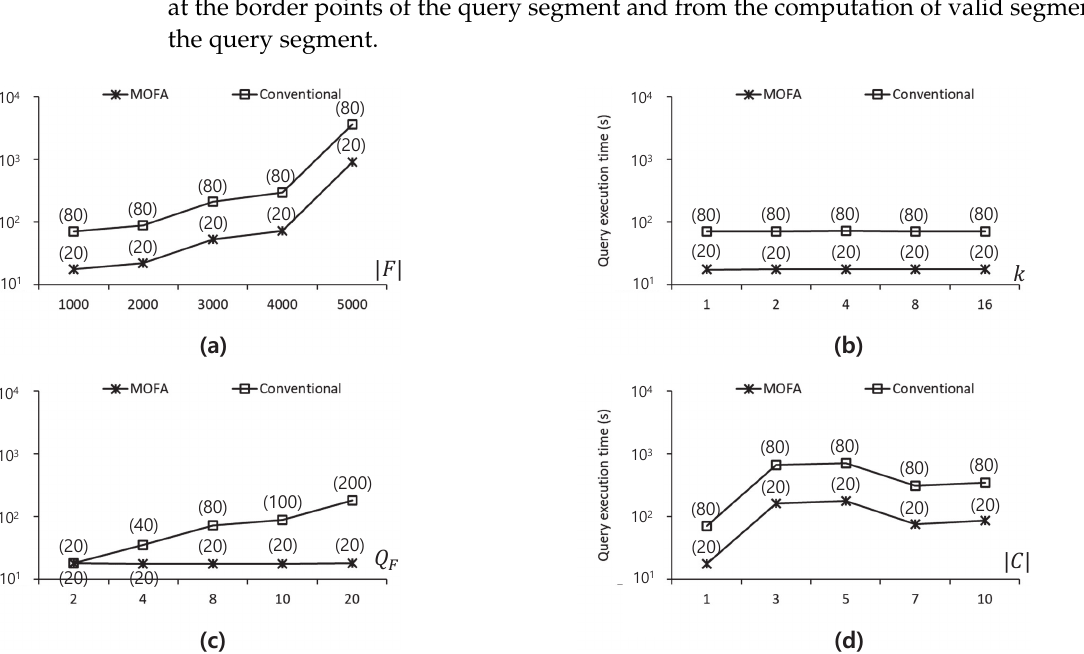
Figure 15. Performance comparisons between MOFA and the conventional algorithm on the NA